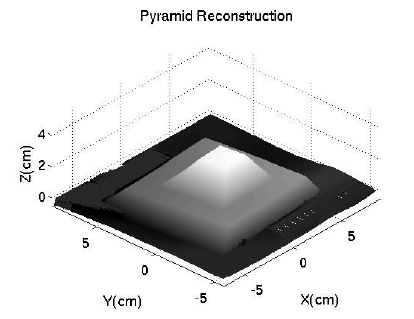
Figure 13. 3D reconstruction of pyramid, axis are at centimeters.